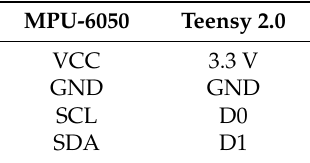
Table 2. Connections between the MPU-6050 and Teensy 2.0 modules.